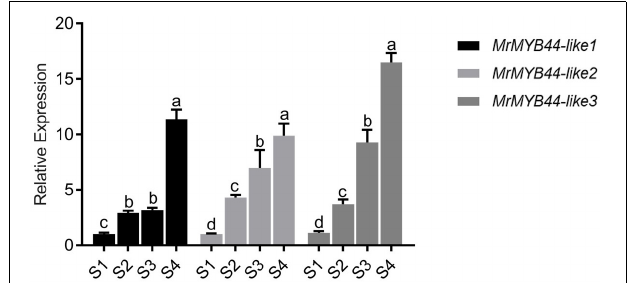
FIGURE 4 | Transcript levels of MrMYB44-like1 , MrMYB44-like2 , and MrMYB44-like3 at different stages of development (S1–S4) in Malus ‘Radiant.’ Values were calculated relative to the transcription level of S1 (set to one). Error bars represent the standard errors. Different lowercase letters indicate significant differences among treatments according to one-way ANOVA test ( P <